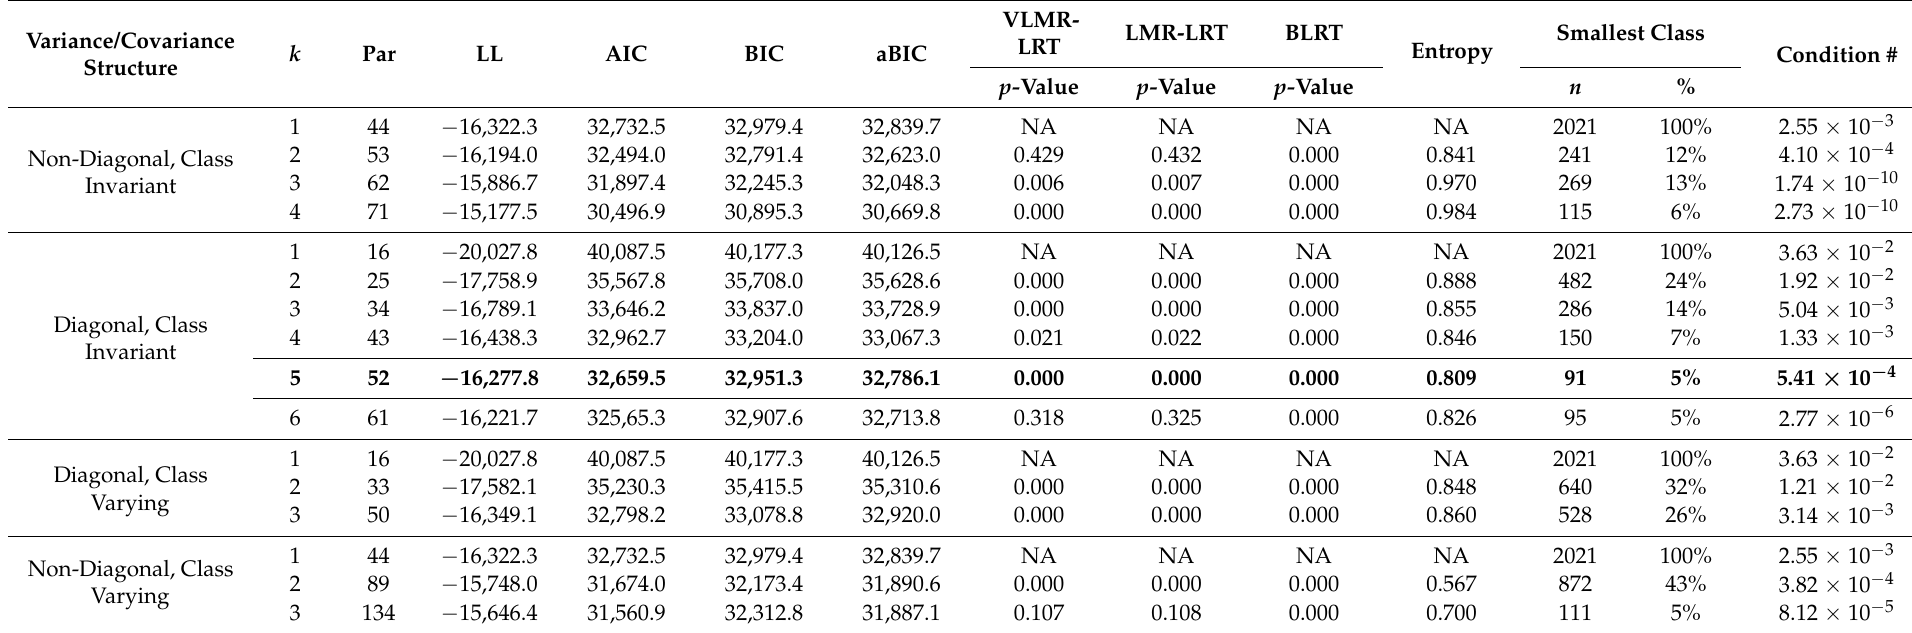
Table 3. Fit Indices for Unconstrained Pre-COVID LPA Models for Each Variance–Covariance